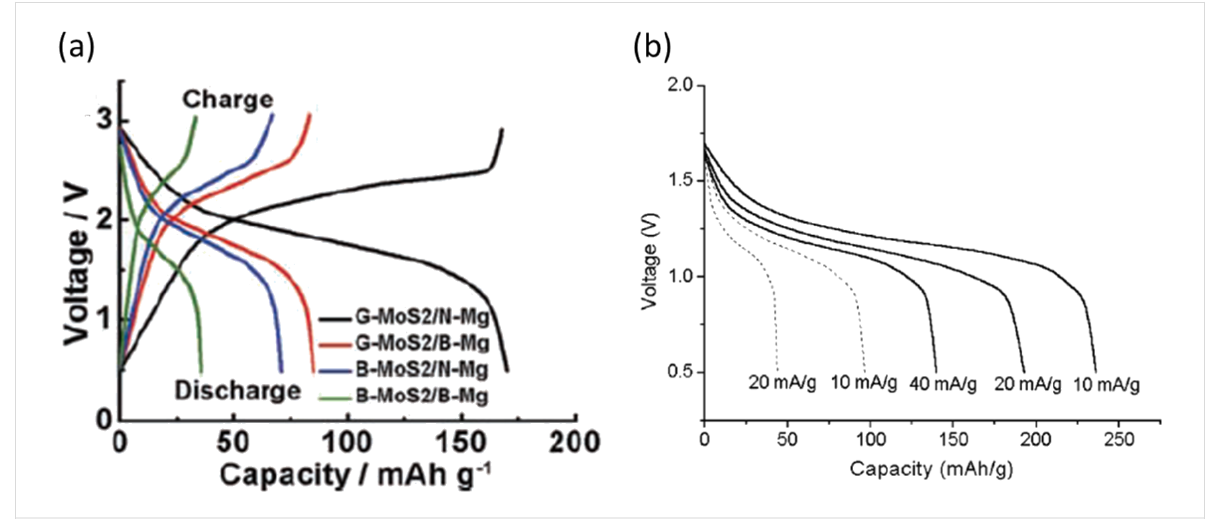
Figure 10: (a) Charge–discharge curves of graphene-like MoS 2 in the Mg(AlCl 3 Bu) 2 /tetrahydrofuran electrolyte solution. Reprinted with permission from [74]. Copyright 2011 Wiley-VCH Verlag GmbH & Co. KGaA, Weinheim. (b) Discharge curves of TiS 2 nanotubes in the Mg(ClO 4 ) 2 /acetonitrile electrolyte solution at various current densities. Reproduced with permission from [77]. Copyright 2004 The Royal Society of